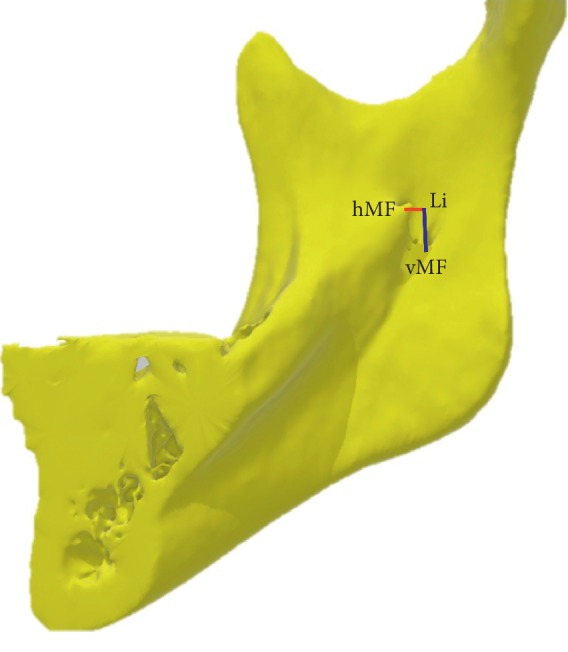
Distance between lingula and mandibular foramen. Measured reference point (mandibular foramen: MF) for lingula tip (Li). Red line (Li-hMF): horizontal distance from Li to MF. Blue line (Li-vMF): vertical distance from Li to MF.